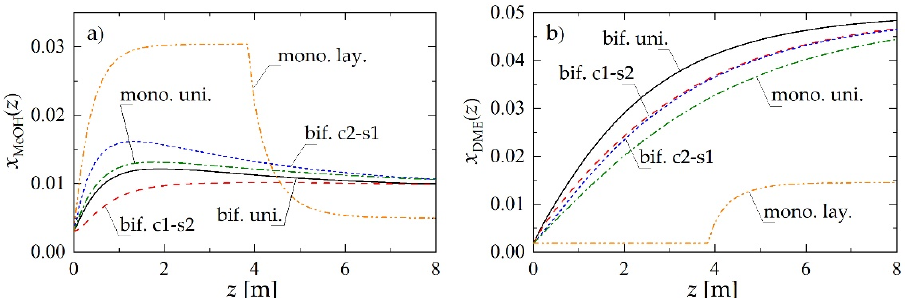
Figure 2. Molar fraction profiles along the reactor obtained using different reactor- and pellet-level structuring of catalytic active sites for R p = 1.5 mm and u in = 0.05 m·s −1 : ( a ) MeOH molar fraction; ( b ) DME molar fraction.